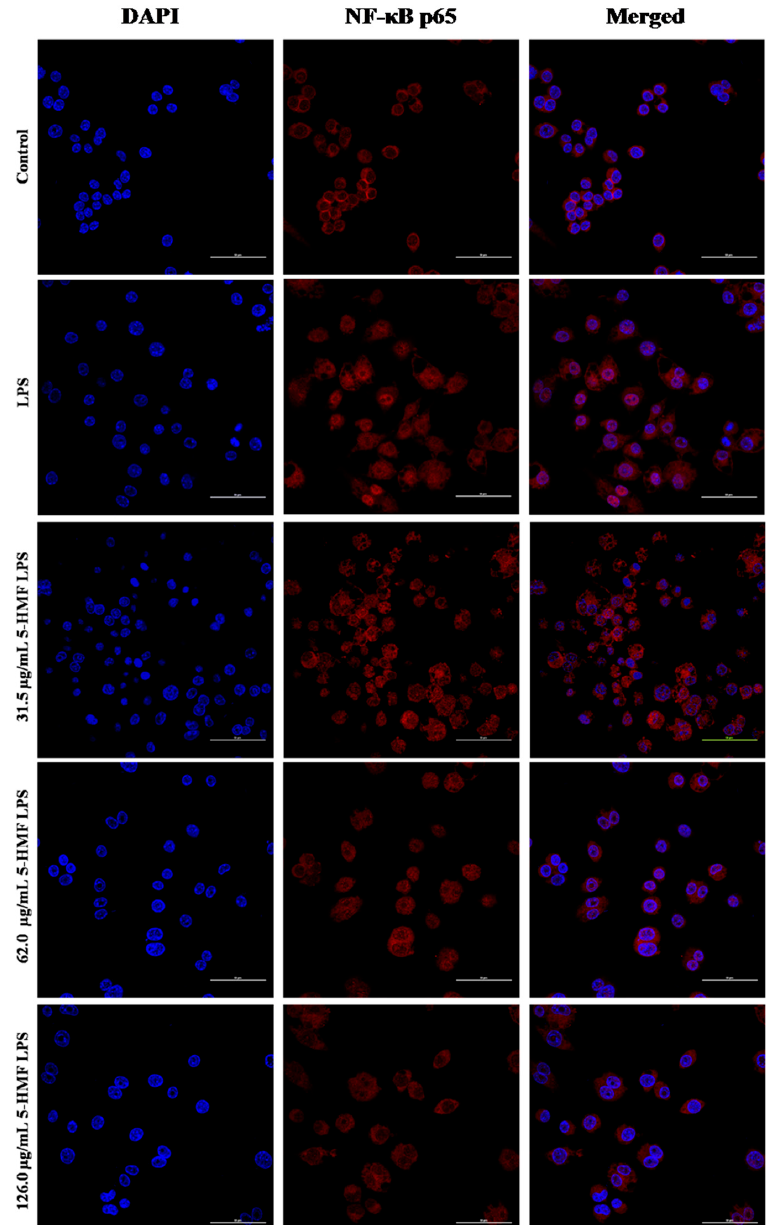
Figure 7. 5-HMF inhibited LPS-stimulated NF- κ B p65 nuclear translocation in RAW 264.7cells. Scale bar = 50 μ m. Nuclear translocation of NF- κ B p65 was assessed using laser scanning confocal microscopy. RAW 264.7 cells were pretreated with different concentrations of 5-HMF for 6 h before the activation of LPS (1 μ g/mL) for 18 h. The cells were stained with NF- κ B p65 antibodies (red) and DAPI (blue).